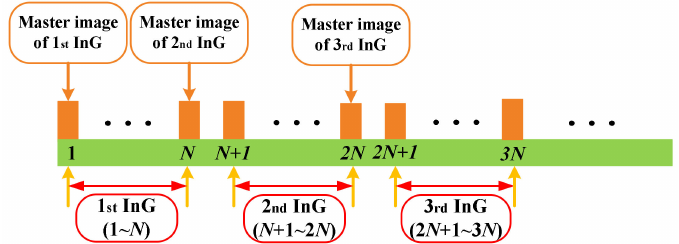
Figure 4. Simplified processing framework based on each interferometric group